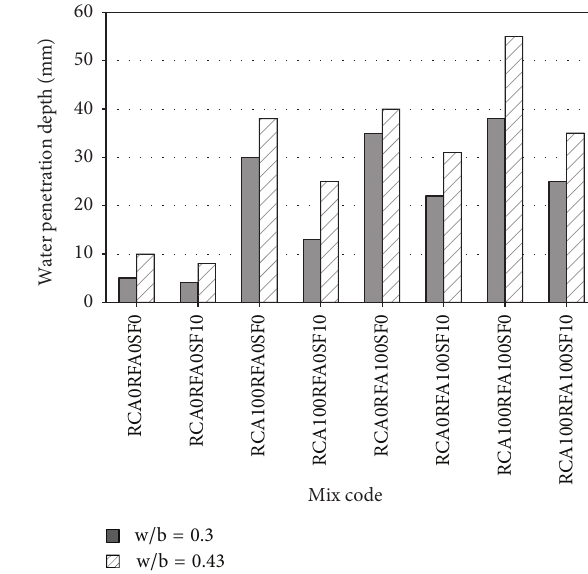
Figure 10: Variation of apparent gas permeability coefficients of SCCs at 56 days.